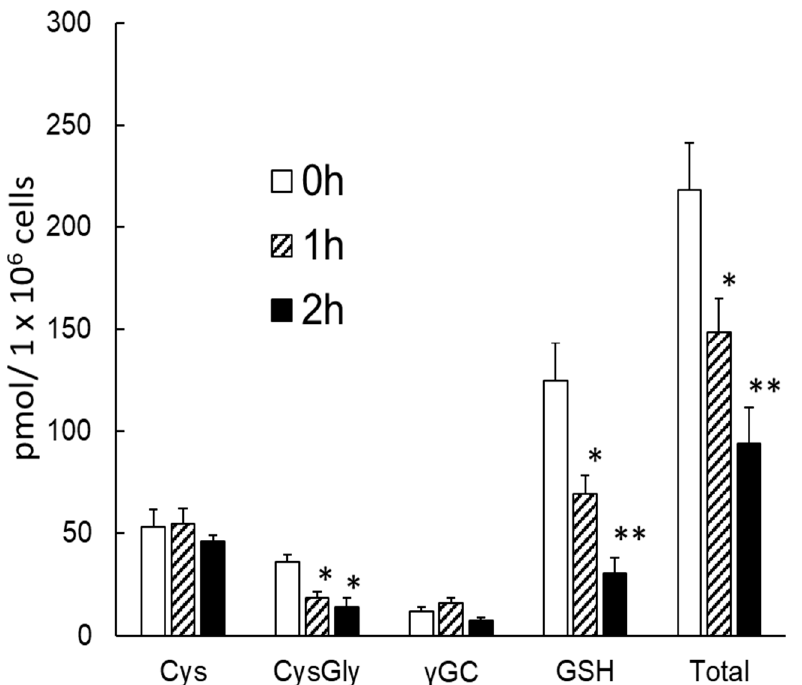
Figure 3. Changes of thiol concentrations after NEM addition ( n = 6, mean ± SEM). Differences in multiple groups were assessed by the non-paired Student’s t -test with the Bonferroni correction. * p < 0.05, ** p < 0.01 vs. 0 h.